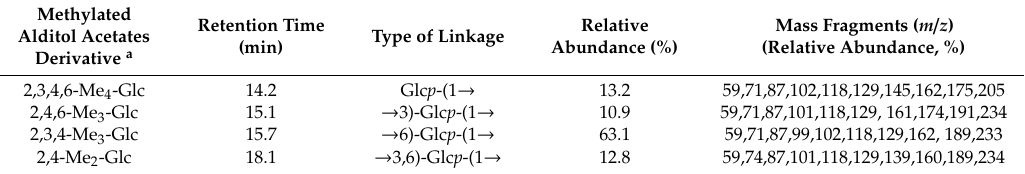
Table 1. The GC-MS data of the main alditol acetate derivatives from methylated products of LeP-N2.